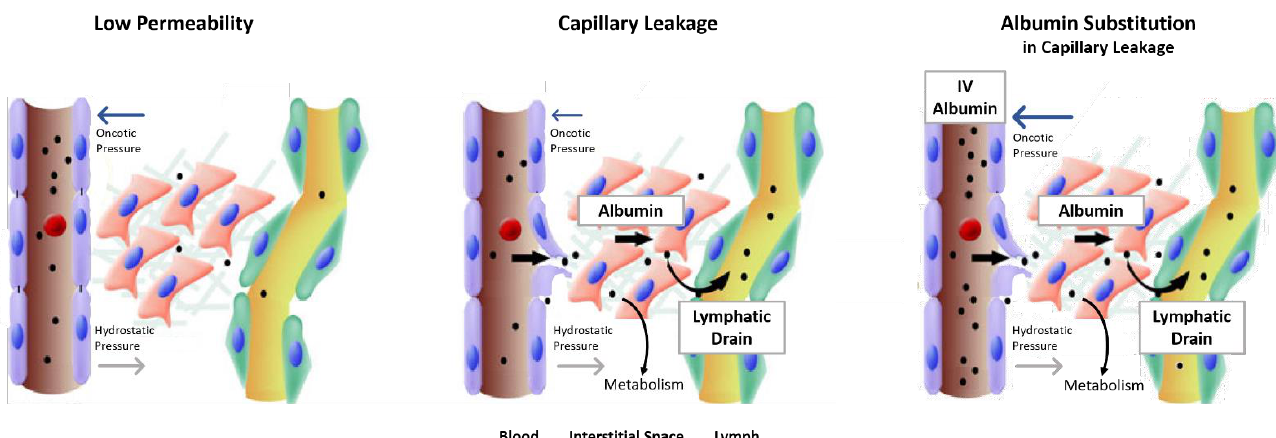
Figure 1. Albumin flux during various conditions. The size of the arrows reflects the direction and sizes of pressures and albumin fluxes. Adapted with permission from Ref. [4]. Copyright © 2022, Springer Nature.